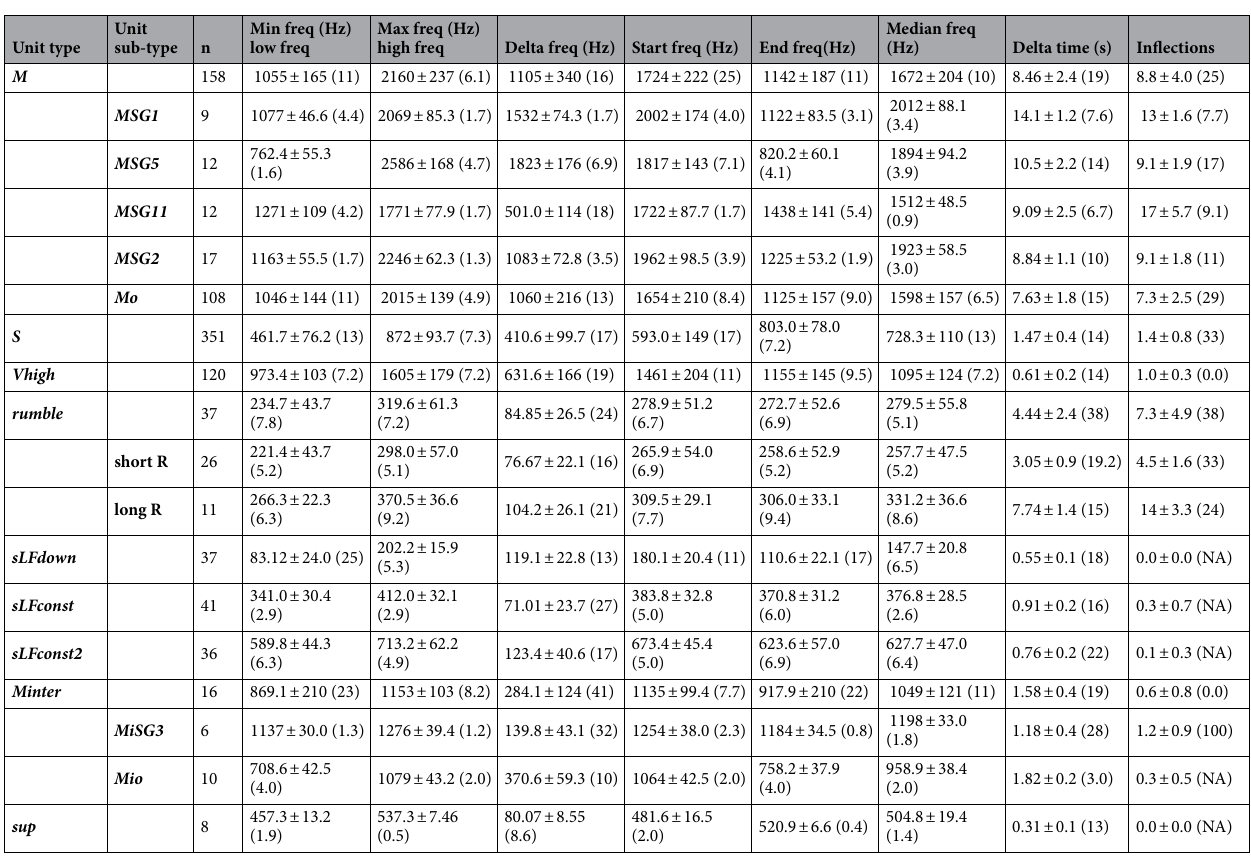
Table 2. Summary of key acoustic characteristics of 9 unit types of bowhead whale songs, including mean ± standard deviation, and coefficient of quartile variation (cqv in